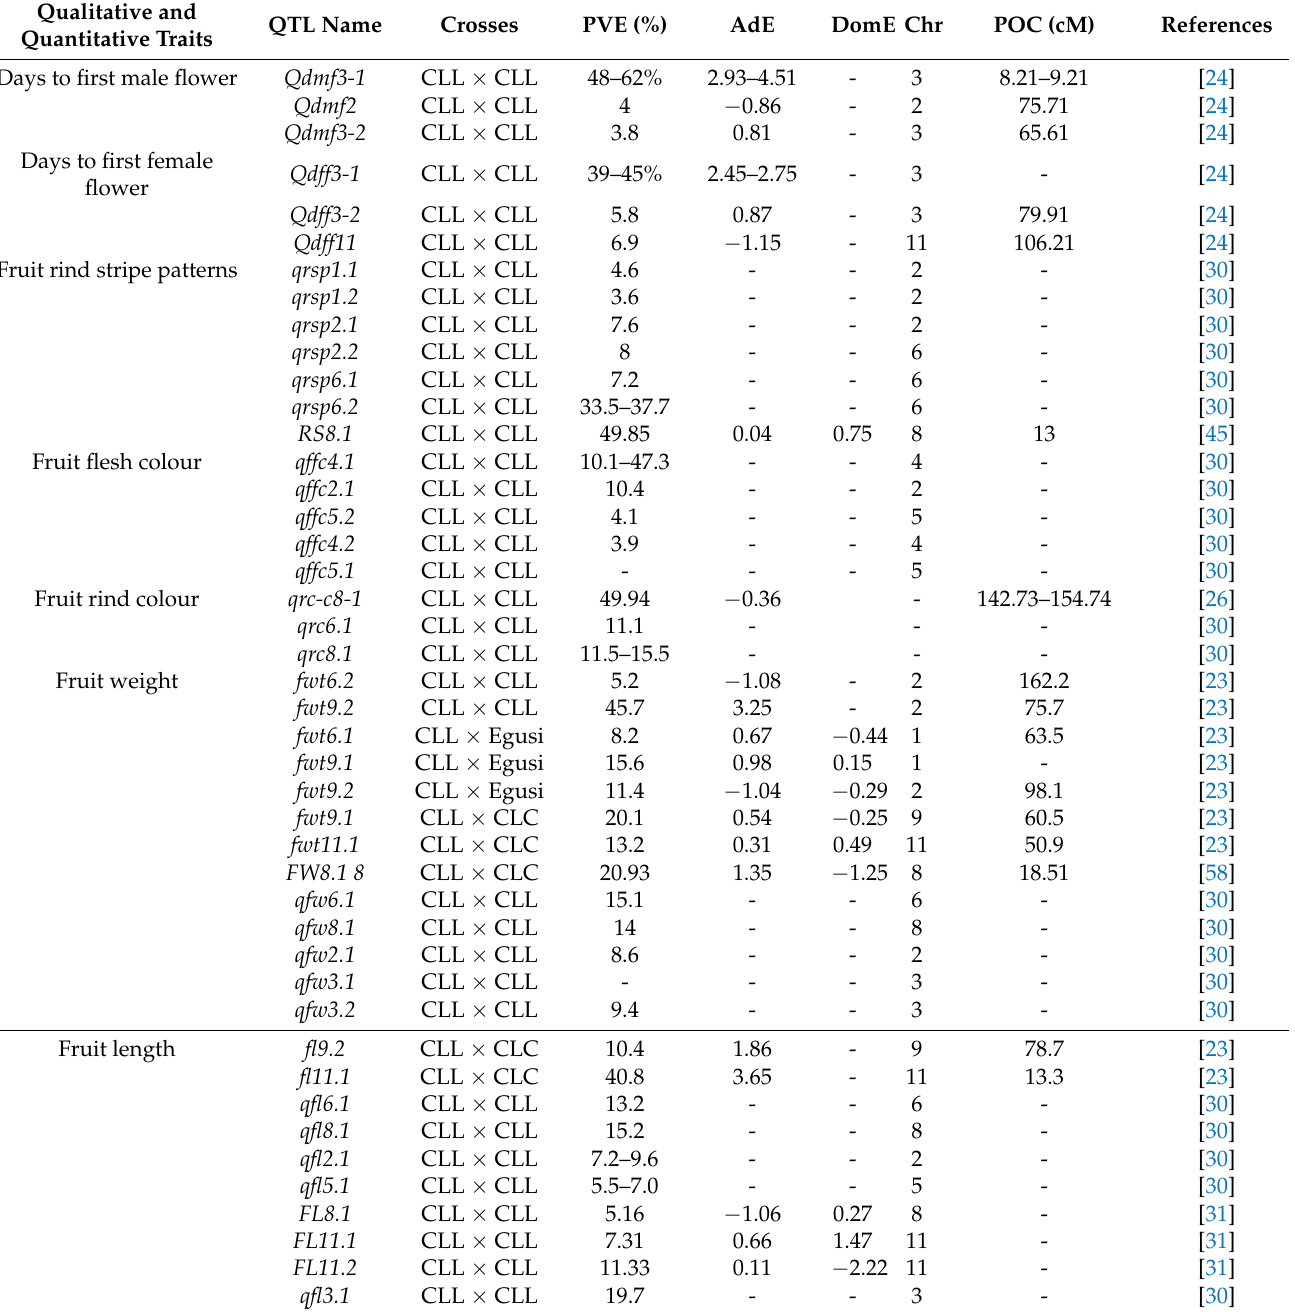
Table 1. Quantitative trait loci (QTL) associated with qualitative and quantitative phenotypic traits in